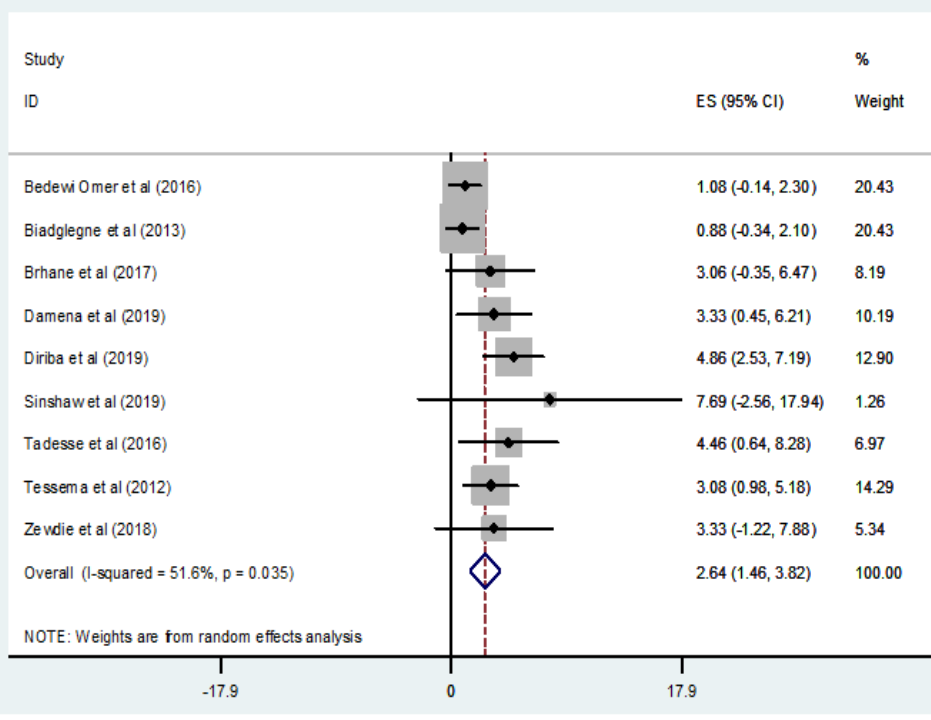
Figure 7. Forest plot showing the weighted pooled prevalence of multidrug-resistant tuberculosis (MDR-TB) in newly diagnosed TB cases.